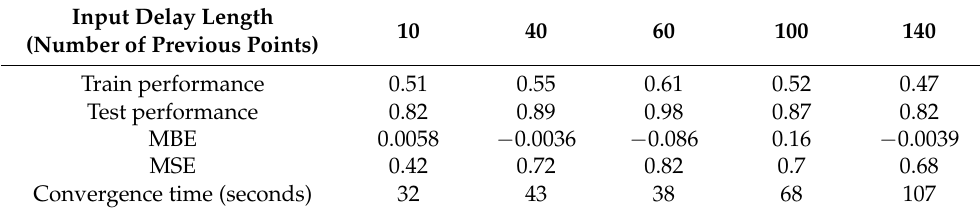
Table 4. The impact of input delay length